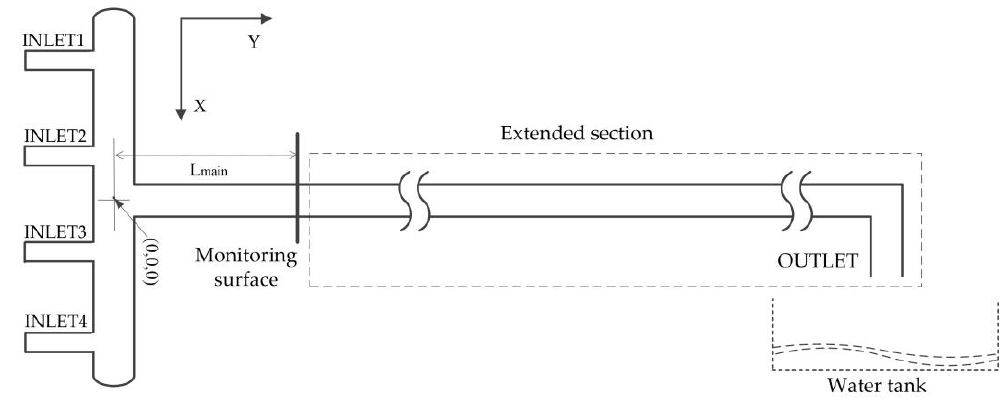
Figure 5. The computational domain of the simulation study.